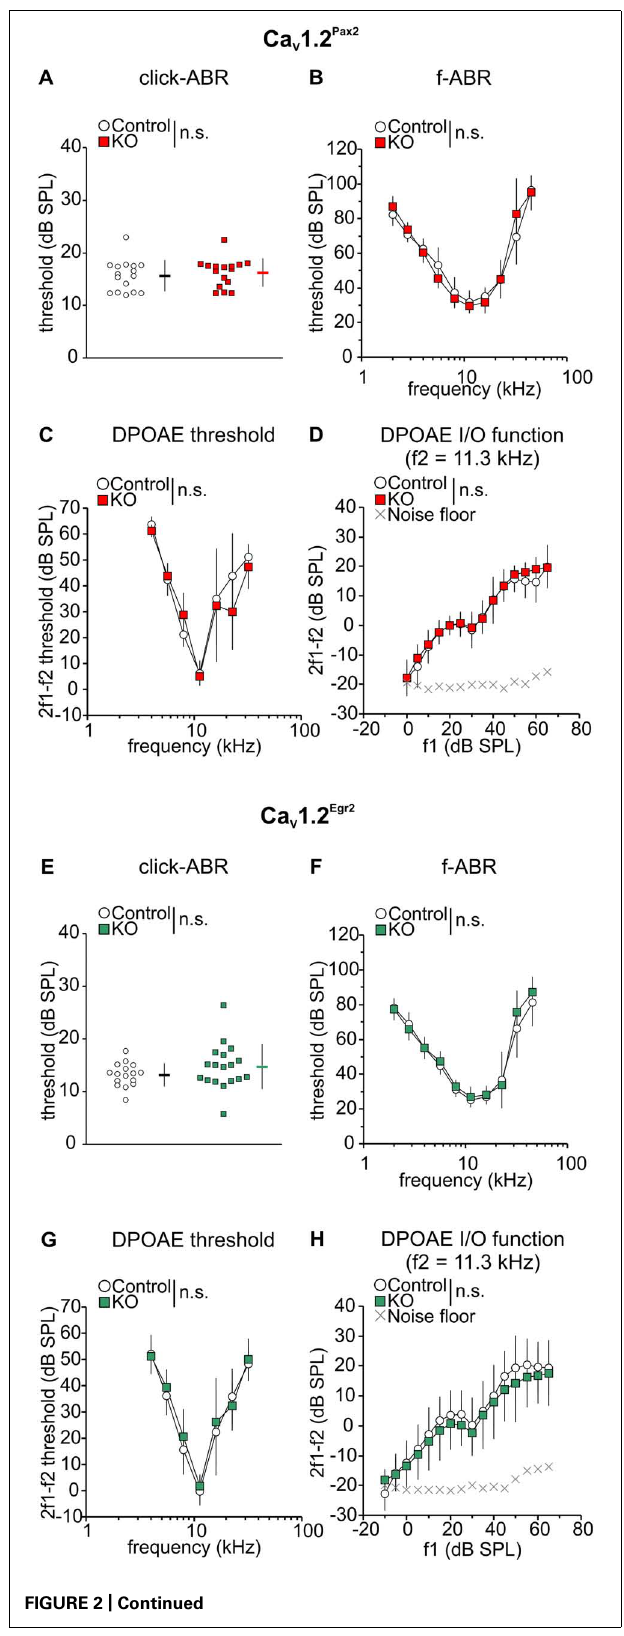
FIGURE 2 | Continued No deterioration ofABR thresholds and OHC function in Ca V 1.2 Pax2 KO and Ca V 1.2 Egr2 KO mice. (A) Mean ± SD click-evoked ABR (click-ABR) thresholds for Ca V 1.2 Pax2 control (black horizontal dash, single ear thresholds as white circles) and Ca V 1.2 Pax2 KO mice (red horizontal dash, single ear thresholds as red squares).Thresholds were not significantly different (two-sided Student’s t -test: p = 0.556) between KO mice (16.2 ± 2.71, n = 16 ears, 8 mice) and control (15.6 ± 2.97, n = 16 ears, 8 mice). (B) Mean ± SD tone-burst-evoked ABR (f-ABR) thresholds for Ca V 1.2 Pax2 KO mice (red) and controls (white).Thresholds were not significantly different (two-way ANOVA, p = 0.890) between KO mice ( n = 6–8 ears, 6–8 mice) and controls ( n = 7–8 ears, 7–8 mice). (C) Mean ± SD DPOAE thresholds for Ca V 1.2 Pax2 control mice (control, white) and Ca V 1.2 Pax2 KO mice (KO, red).Thresholds were not significantly different (two-way ANOVA: p = 0.452) between KO mice ( n = 4 ears, 4 mice) and controls ( n = 4 ears, 4 mice). (D) Mean ± SD DPOAE amplitude I/O function evoked by stimulus f2 = 11.3 kHz for Ca V 1.2 Pax2 KO mice (red) and controls (white) showing no significant difference (two-way ANOVA: p = 0.158) between KO mice ( n = 4 ears, 4 mice) and controls ( n = 4 ears,